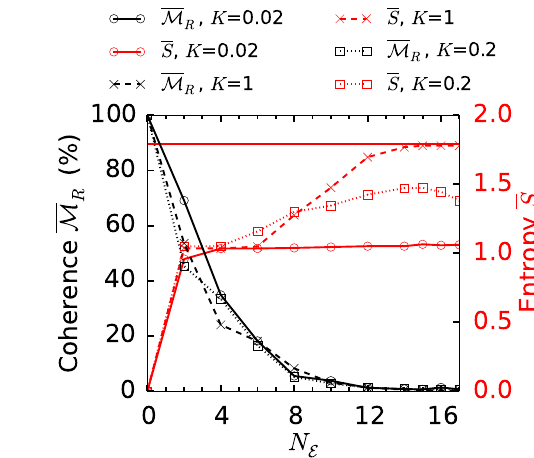
Figure 8: The time-averaged entropy and maximum off-diagonal component as a func- tion of the environment size N (cid:69)